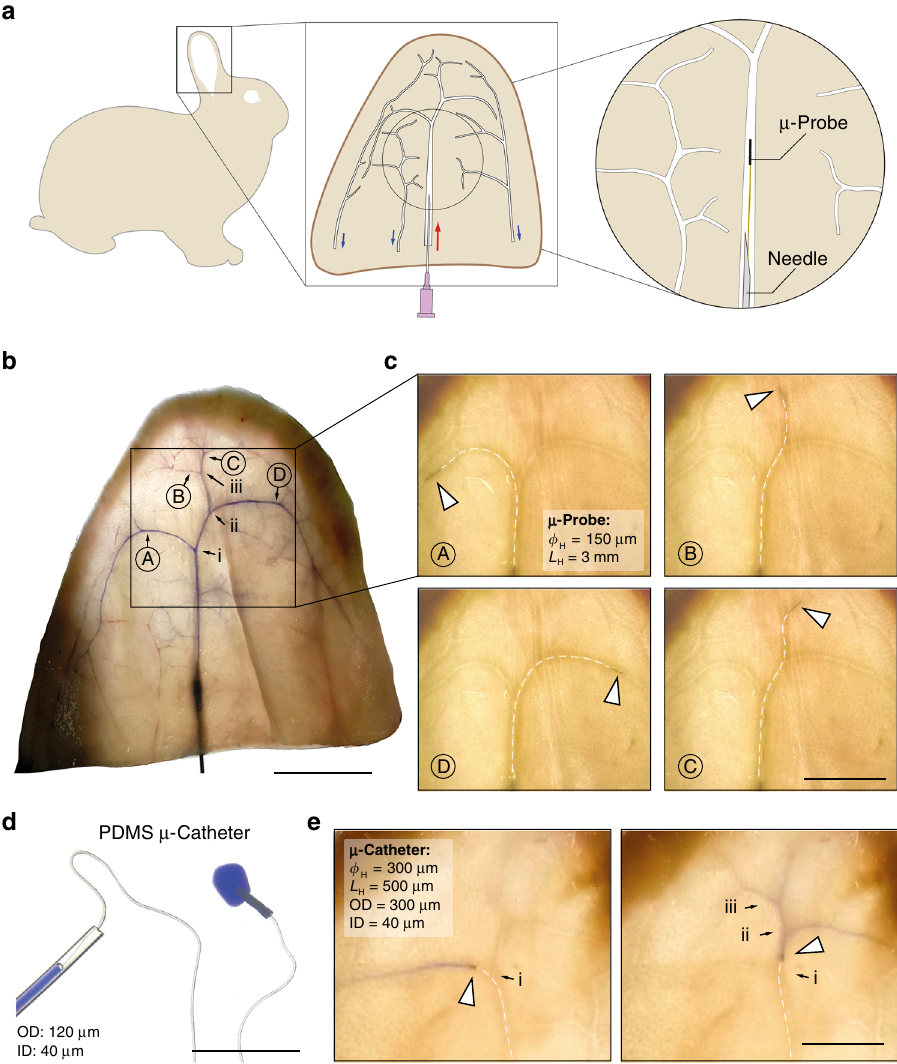
Fig. 7 Navigation and operation of µ -probes in perfused ex vivo rabbit ears. a Schematic representation of the vascular system in the rabbit ear. Red arrow marks the central artery rami fi cation and blue arrows indicate the venous system. b Ink-perfused ear at the proximal central artery, highlighting the main arterial branches. Bifurcation is marked with roman letters (i, ii, and iii) while the targets locations are marked with capital letters (A, B, C, and D). Scale bar, 20 mm. c A µ -probe with 150- μ m diameter and 3-mm long magnetic head was proximally inserted into the vasculature using the perfusion-based insertion system at a fl ow velocity between 0.5 and 1.5 cm ⋅ s − 1 . White dashed lines outline the µ -probe for clarity. Scale bar, 10 mm. d A picture of the magnetic µ -catheter tube. A blue ink is injected through the µ -catheter. Scale bar, 5 mm. e Positioning of the µ -catheter head at target locations and localized injection of the ink. A total of 9 rabbit ears were used. Scale bar, 10